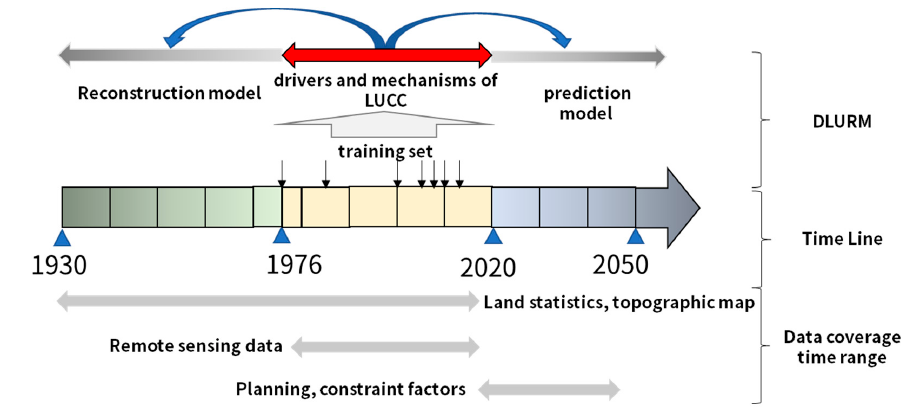
Figure 2. Deep learning-integrated LUCC reconstruction model (DLURM) mechanism.